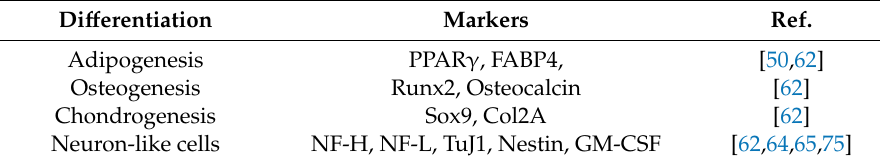
Table 2 summarizes master markers expressed during PO-MSCs’ multi-lineages di ff erentiation. Table 2. Biomarkers identified after di ff erentiation stimuli from mesenchymal stem / progenitor cells (MSCs) derived from nasal tissue or nasal polyps. Polyp derived mesenchymal stem cells (PO-MSCs) can di ff erentiate, under specific stimuli, into adipocytes, osteocytes, chondrocytes, and neuron-like cells. The terminal di ff erentiation of PO-MSCs towards cells of mesodermal or non-mesodermal origin results in the expression of lineage-specific